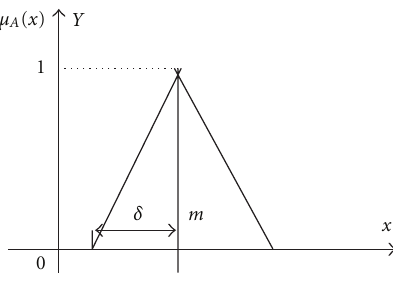
Figure 2: Symmetrical fuzzy